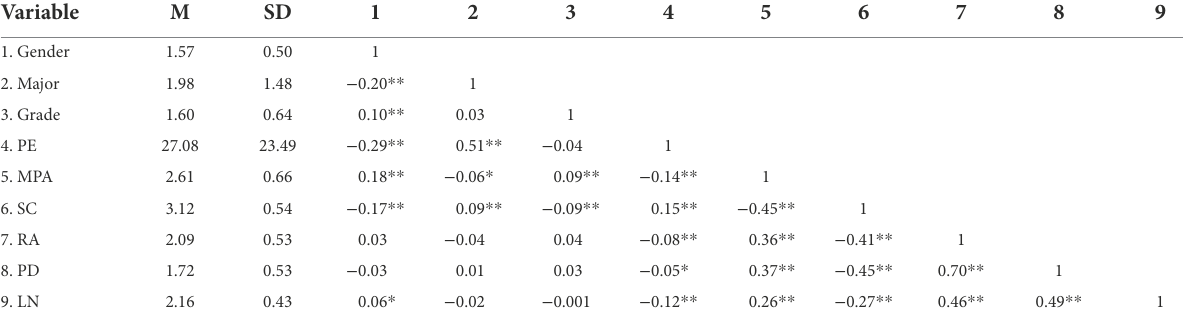
TABLE 2 Descriptive statistics and interrelations among of the observed variable.